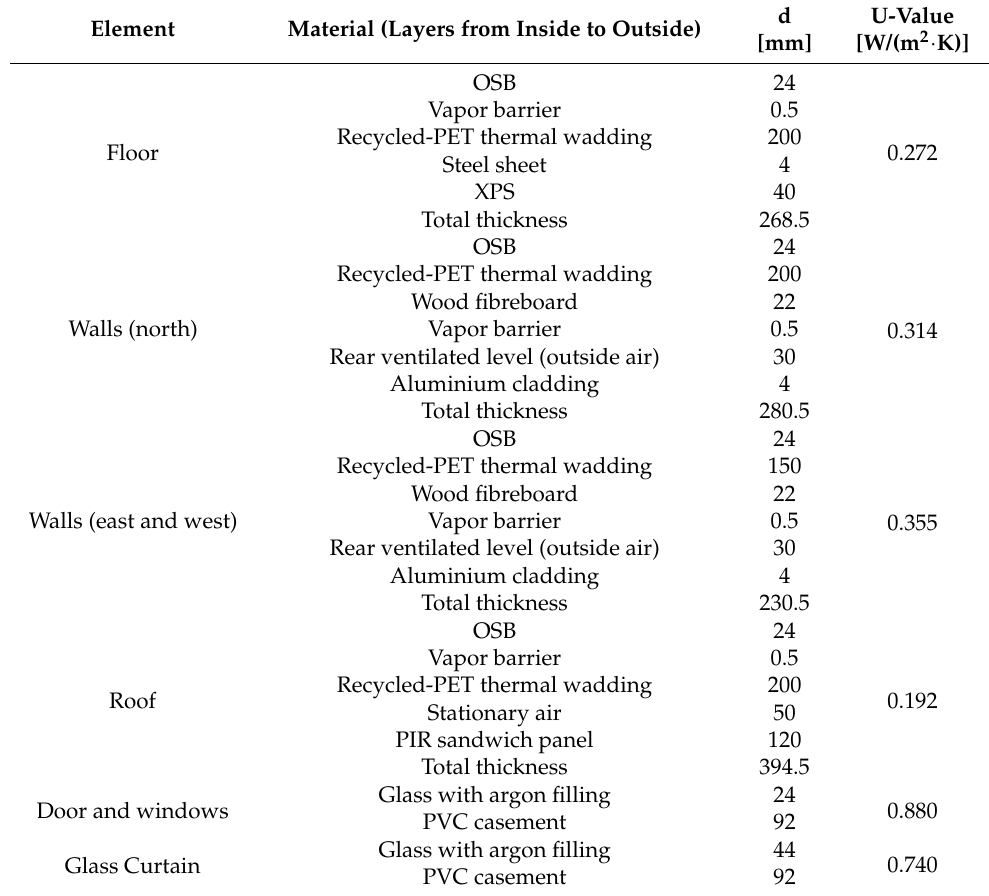
Table 2. Materials, thicknesses (d) and thermal transmittances (U) of the experimental module ele- ments.